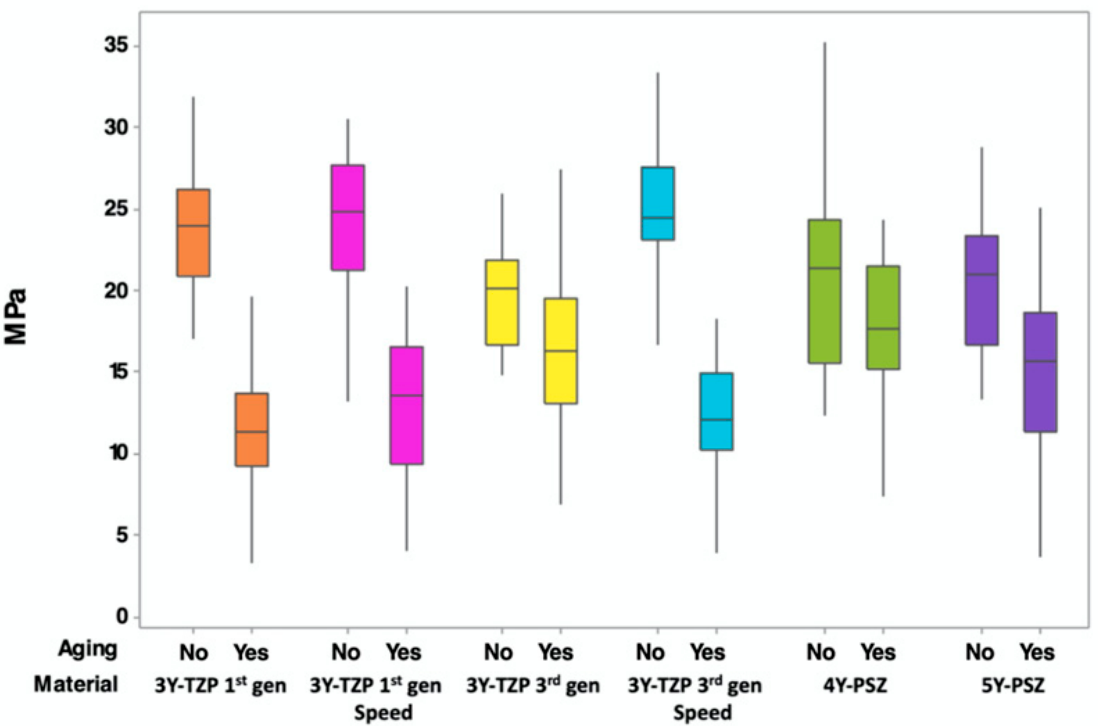
Figure 2. Boxplot of the average bond strength of all studied groups.